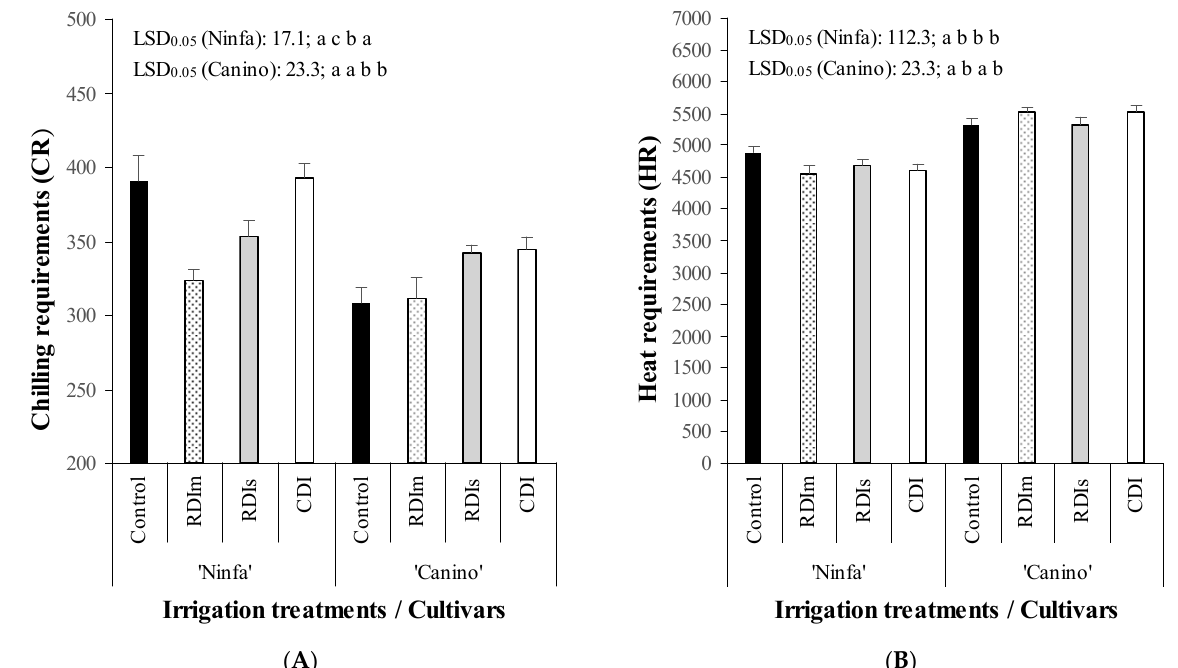
Figure 3. The effect of four irrigation treatments (control, moderate regular deficit irrigation—RDIm, severe regular deficit irrigation—RDIs and continuous deficit irrigation—CDI) and two cultivars (‘Ninfa’ and ‘Canino’) on chilling requirements— CR ( A ) and heat requirement—HR ( B ). Data are means of 2016, 2017 and 2018. Standard deviation values are presented by bars on the columns. Control means that trees were irrigated at 100% of seasonal ETc for all phenological growth stages of the trees. Differences among control, RDIm, RDIs and CDI treatments were represented by LSD 0.05 values at P = 0.05, separately for the two cultivars (‘Ninfa’ and ‘Canino’). After each LSD 0.05 value, first, second, third, and fourth letters belongs to the control, RDIm, RDIs and CDI treatments, respectively. Values within the given cultivar coupled with different letters are significantly different among the control, RDIm, RDIs and CDI treatments at P = 0.05 according to LSD t -tests.